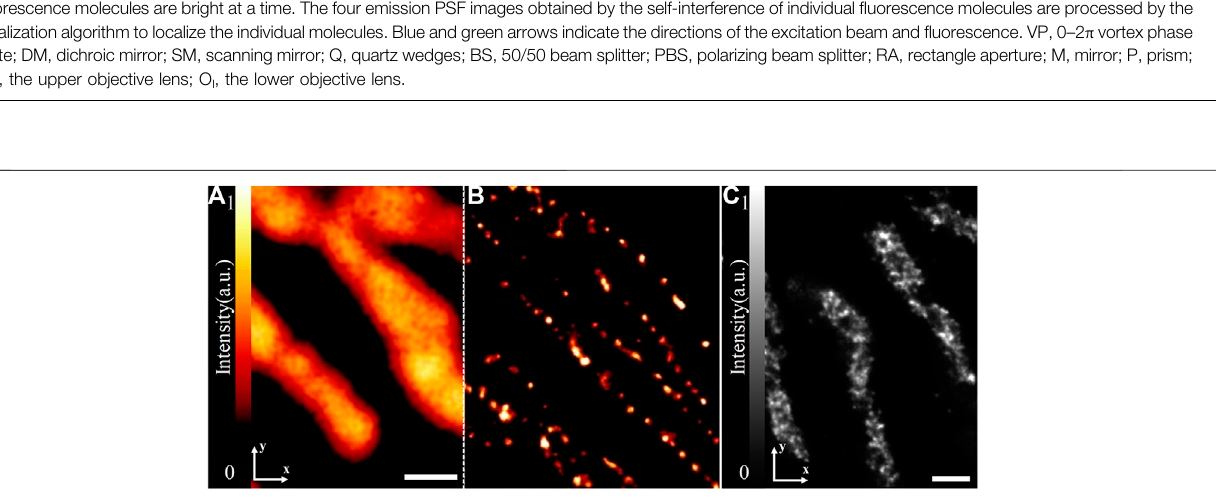
high-NA DO, as shown in Figure 10E . The method was used to monitor the binding properties of the glucocorticoid receptor and estrogen receptor- α to DNA in living MCF-7 cells. Combining the RLSM with individual molecule localization